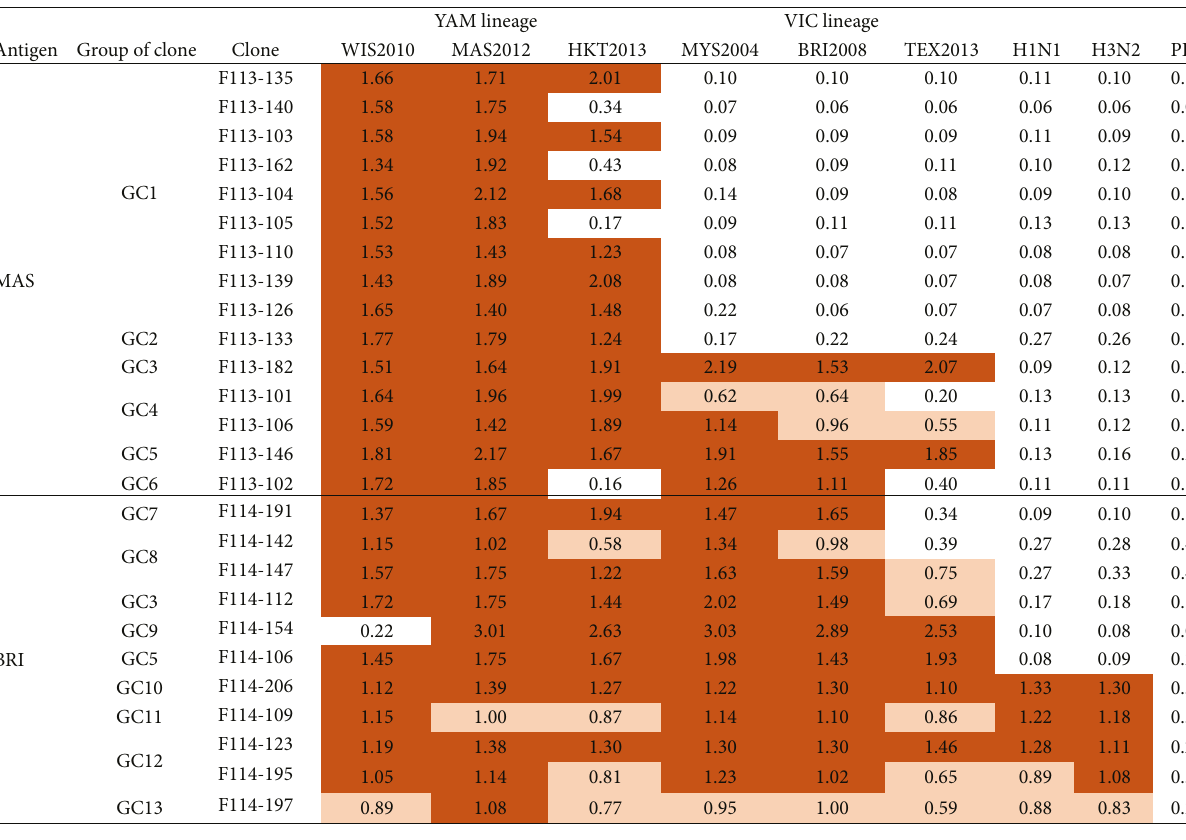
Figure 3: Binding activities measured by ELISA between eight virus particles and the 26 Abs isolated in this study. Viruses tested were WIS2010, B/Wisconsin/1/2010; MAS2012, B/Massachusetts/2/2012; HKT2013, B/Phuket/3073/2013; MYS2004, B/Malaysia/2506/2004; BRI2008, B/Brisbane/60/2008; TEX2013, B/Texas/2/2013; H1N1, A/California/7/2009; and H3N2, A/Texas/50/2012. Absorbance values > 1 are marked by light brown, and values 0.5 – 1 are marked by faint light